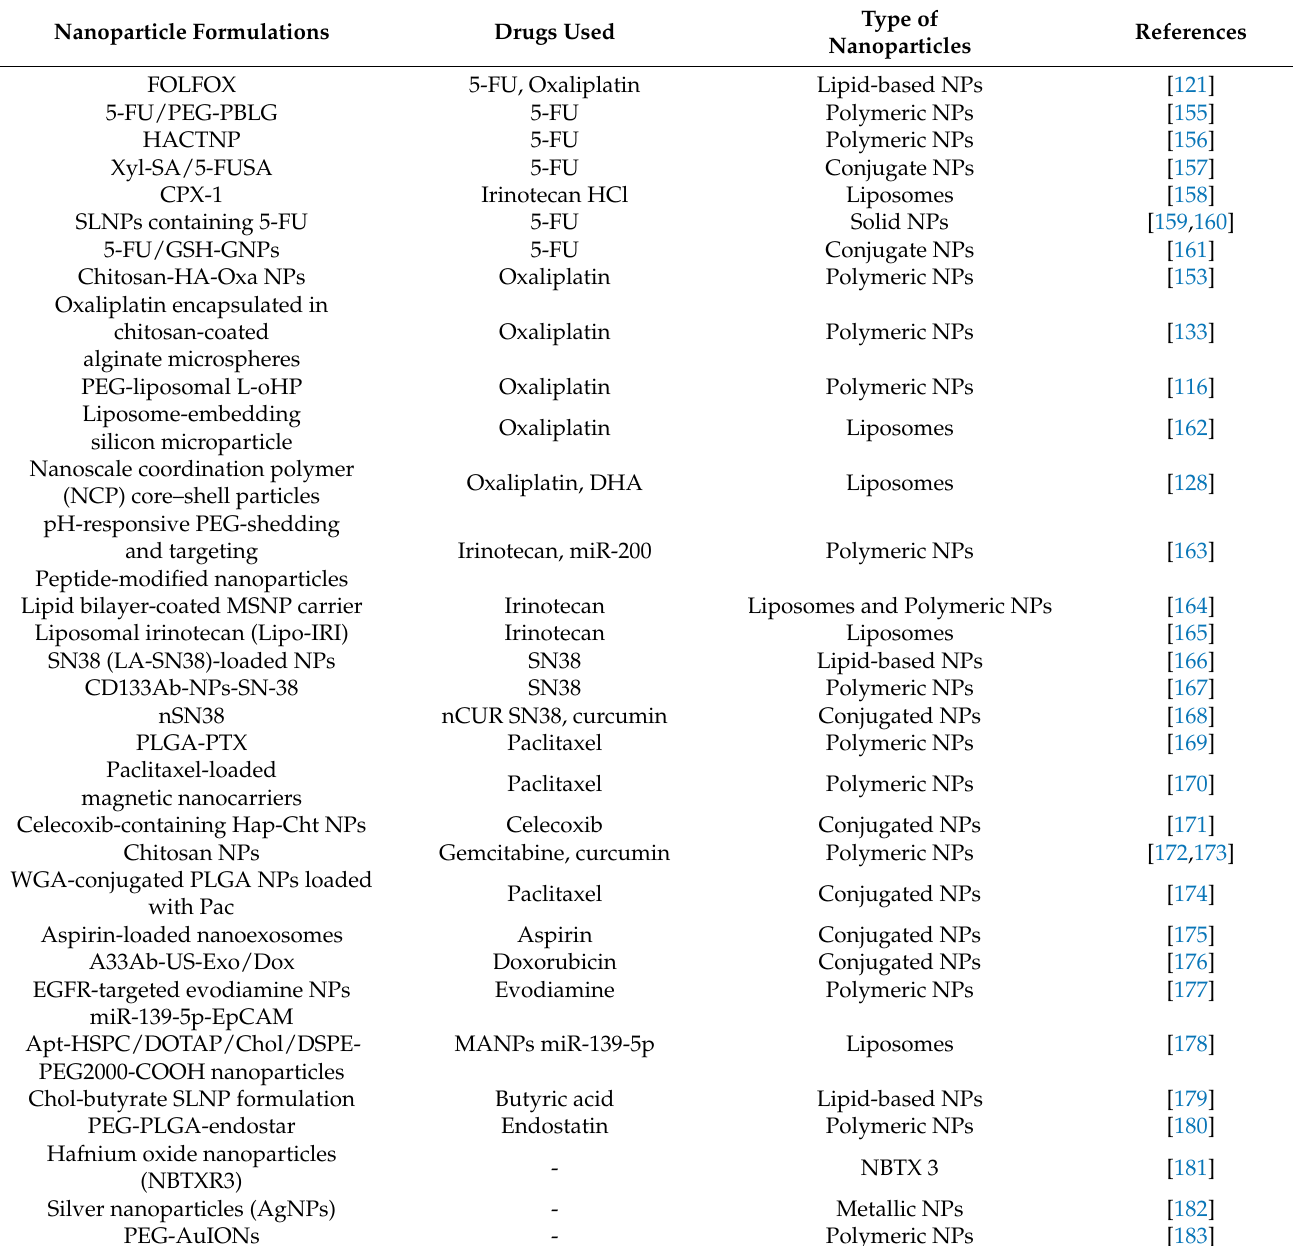
Table 1. Some nanoformulations have been prepared for the treatment of colorectal